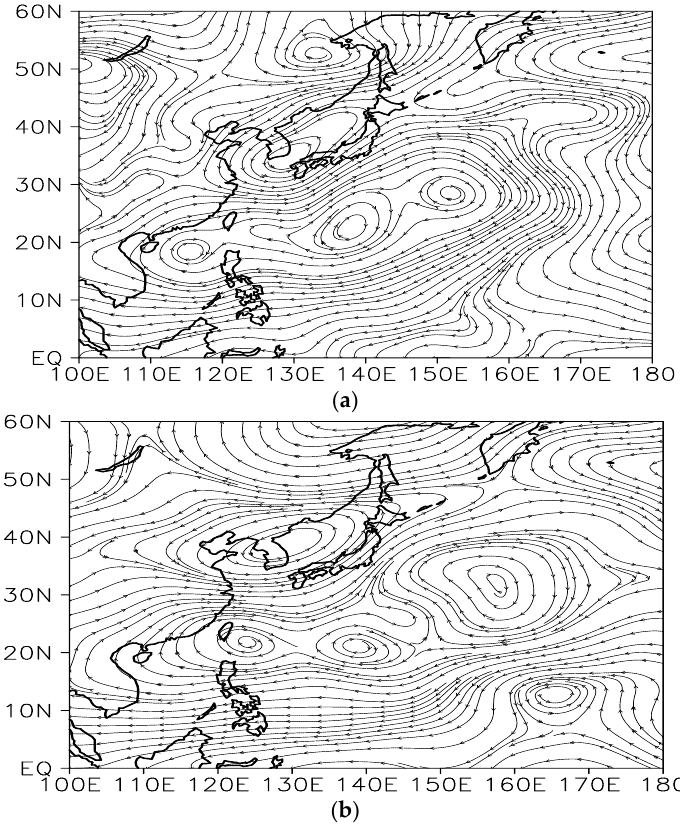
Figure 4. Differences in ( a ) 850 hPa and ( b ) 500 hPa stream flows between 2014 and climatological mean. Anomalous huge anticyclonic circulations that were strengthened in the tropical and subtropical western Pacific during August 2014 may indicate that the western North Pacific subtropical high (WNPSH) was developed further than the climatological mean during the same period. Therefore, this study compared the WNPSH in relation to August 2014 and the climatological mean (Figure 5). Here, the WNPSH is defined as the area with higher values than 5875 gpm. While the climatological mean WNPSH developed on Japan’s western coast, the WNPSH during August 2014 spread westward deep into China’s southern region and was fairly expanded equatorward at the same time. Therefore, during August 2014, TCs could not occur because convection was suppressed according to the WNPSH’s abnormal development in the tropical and subtropical western Pacific.